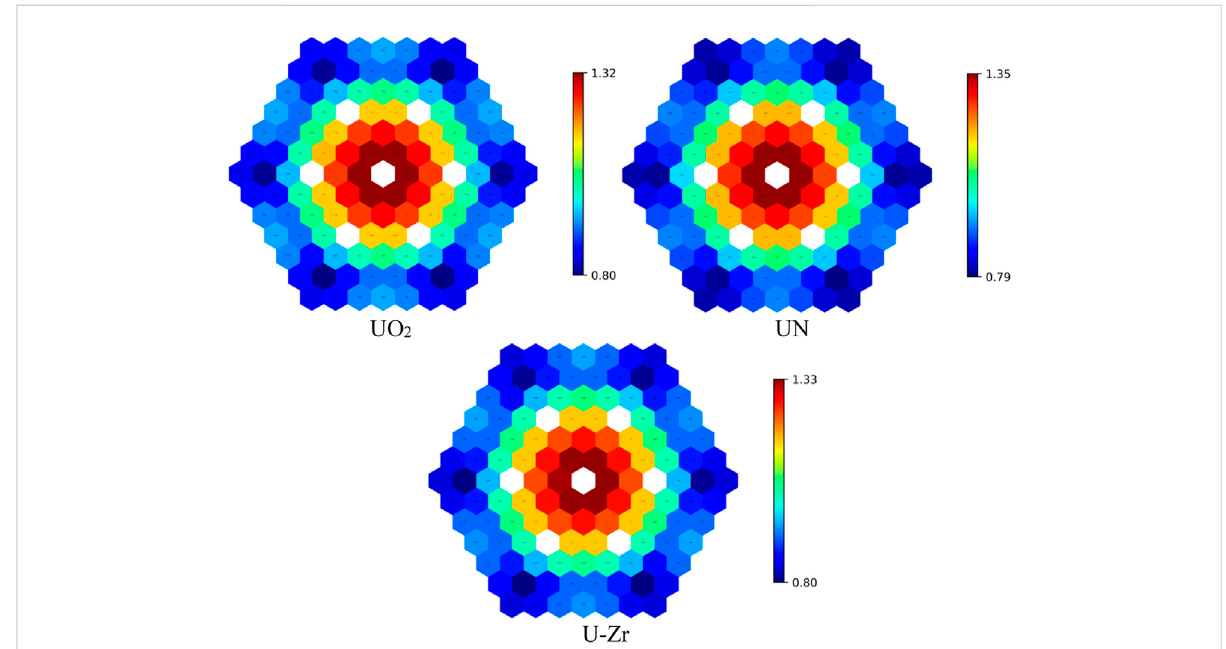
FIGURE 15 Assembly power distribution results on the beginning of life of the fuel material